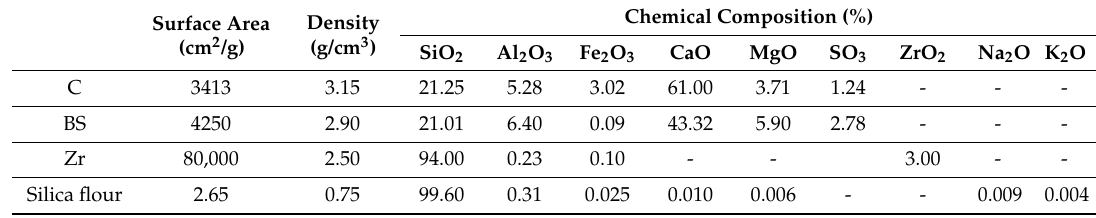
Table 2. Chemical compositions and physical properties of cementitious materials.